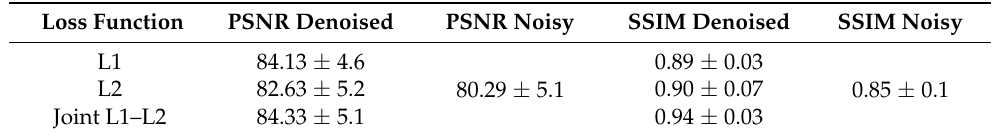
Table 2. PSNR and SSIM for high b -value noisy and denoised images (NEX = 1) with respect to the high b -value reference (NEX = 16) for different loss functions computed using all the patients in the testing set. Joint L1–L2 loss function presents the highest PSNR and SSIM, in agreement with the analysis performed by the body radiologist. Loss Function 0.94 ± 0.03 Figure 5 shows the performance of DCNN for different numbers of repetitions (NEX) or acceleration factors. Denoising performance is high in all cases, with slightly better quality in NEX = 2 and NEX = 4 over NEX = 1, which was expected due to the use of more repetitions.